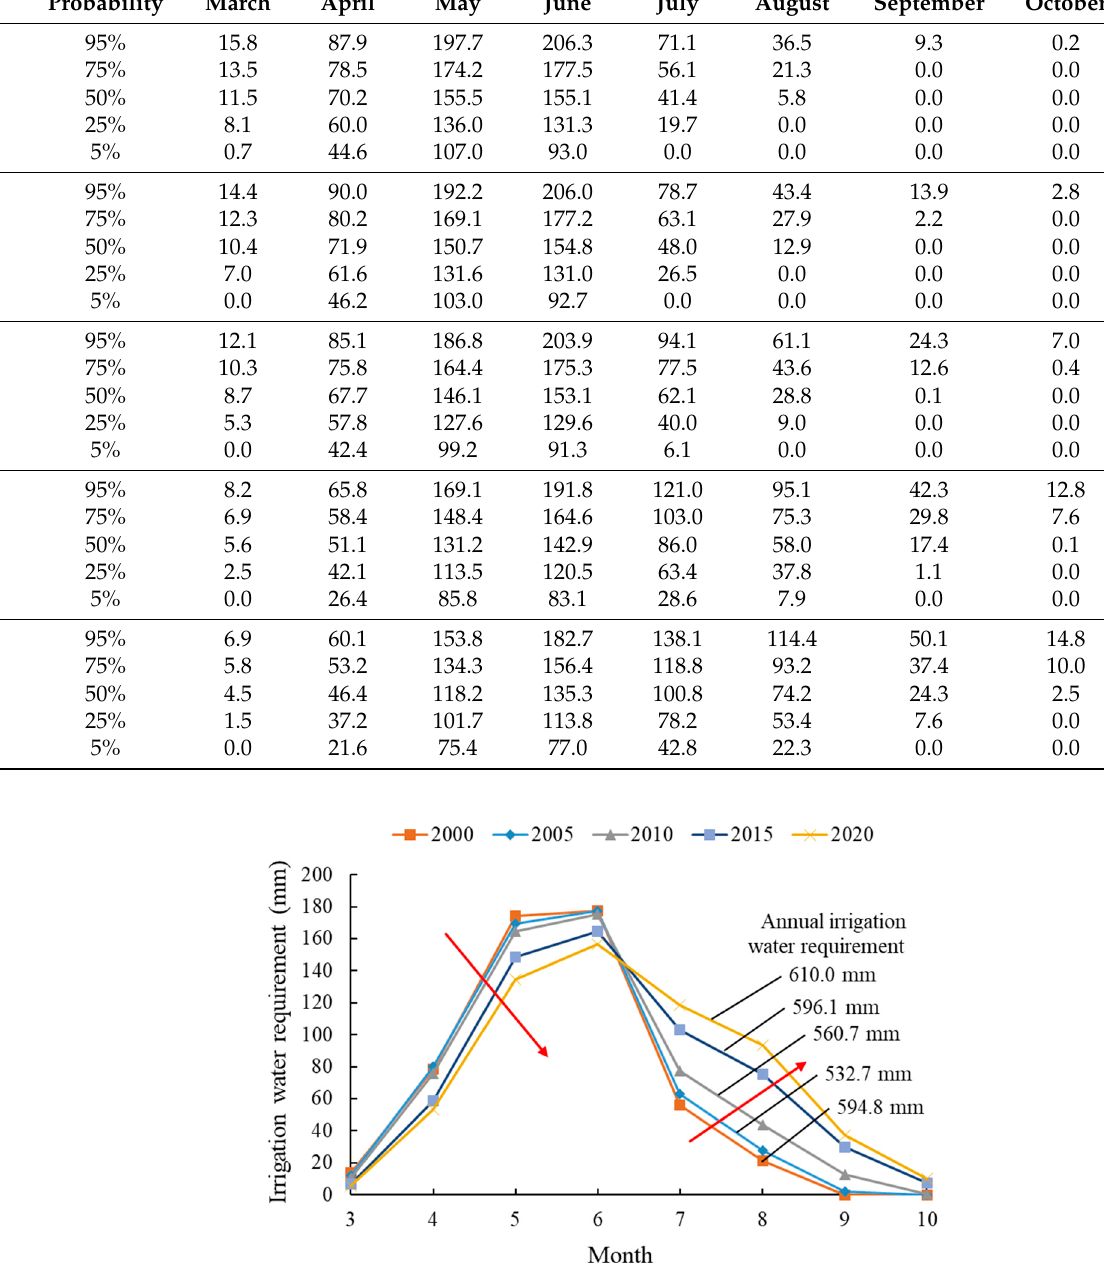
Figure 10. Monthly net irrigation water requirement with a probability of irrigation of 75% for typical years. (Arrows indicate the changing trend of net irrigation water requirement from 2000 to 2020).